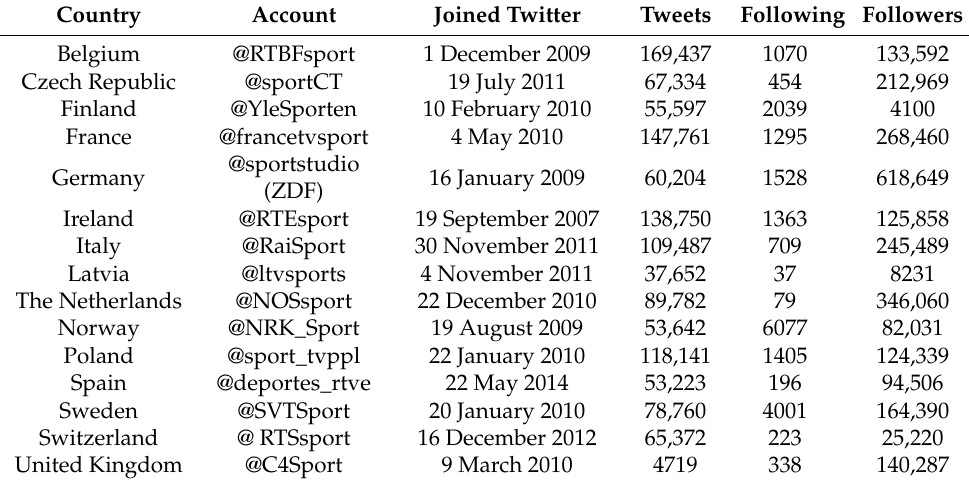
Table 1. Contextual data for the accounts